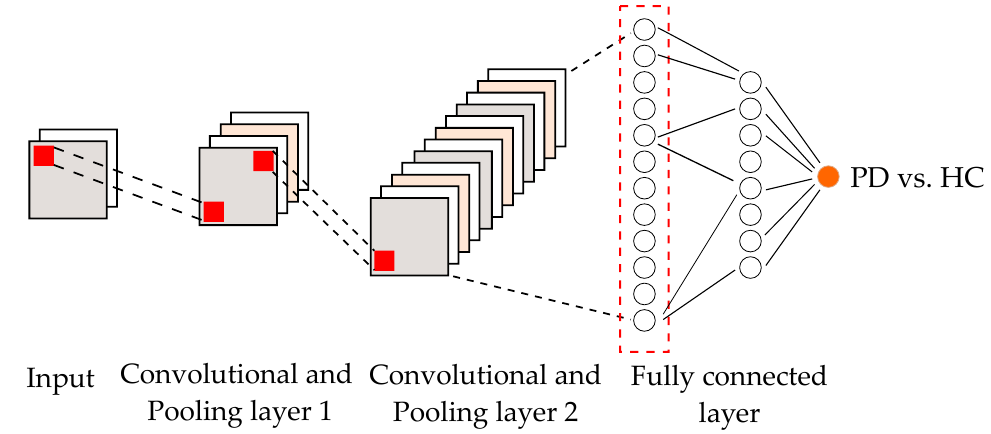
Figure 3. Illustration of a CNN with two convolutional layers.